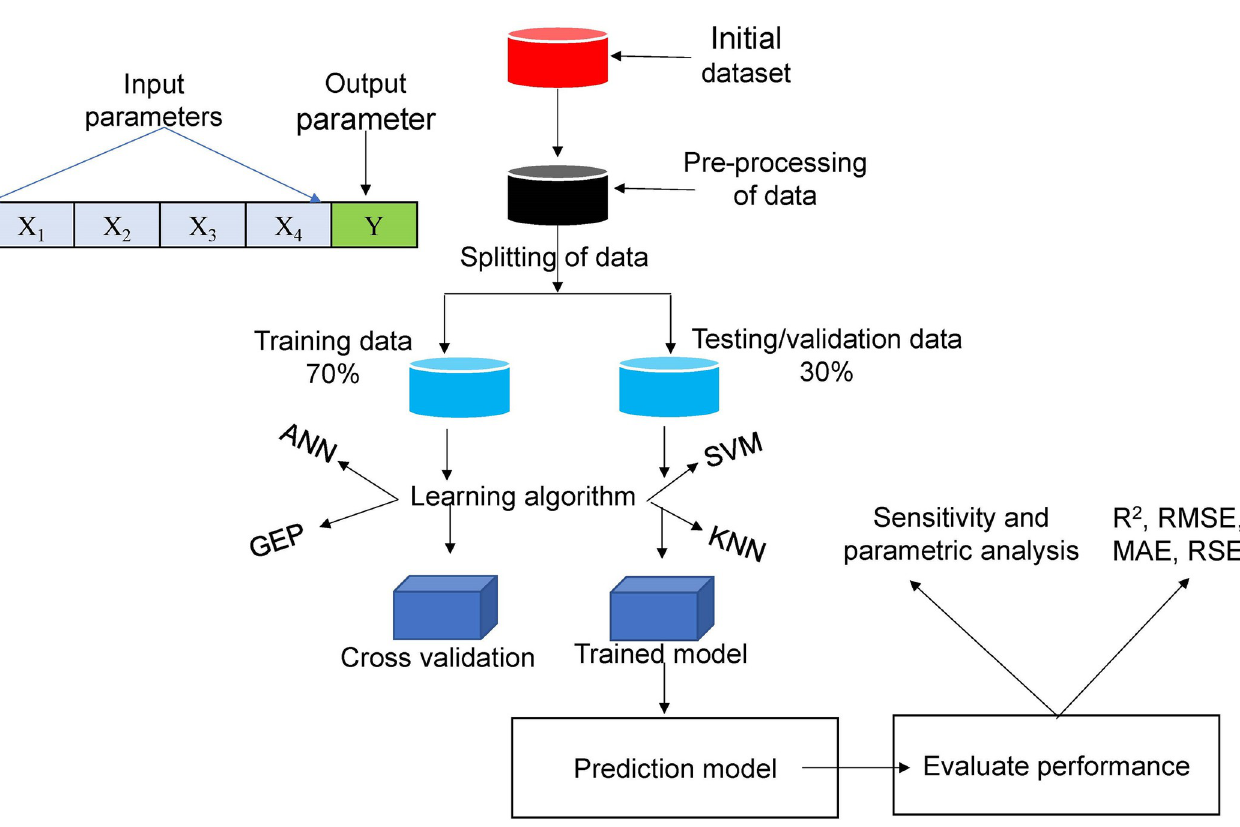
Fig 4. Steps involved in developing prediction model using artificial intelligence